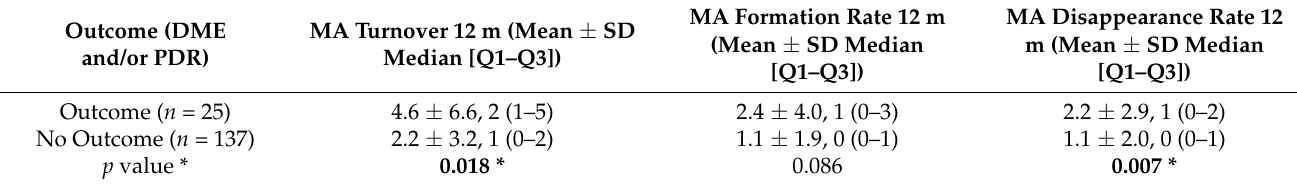
Table 2. Comparison of MA changes with the development of vision-threatening complications.